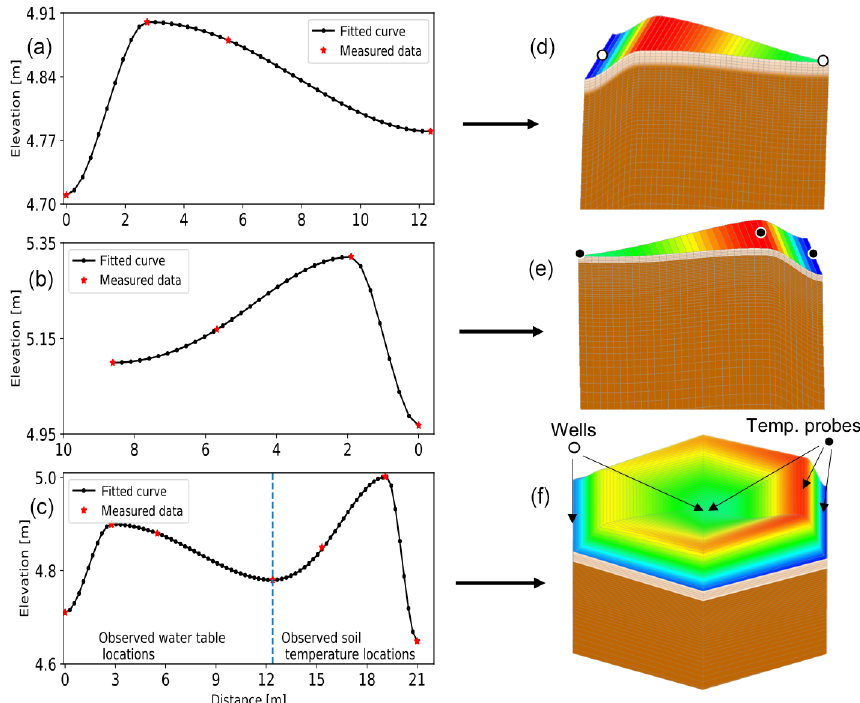
Figure 2. Construction of generic meshes from the observed elevations at the microtopographic locations (trough, rim, and center). Red asterisks represent measured elevation, black dots show spatial resolution ( ∼ 25cm), and black solid lines correspond to a spline fit to the measured elevation with zero slope at the locations trough, rim, and center. Panel (f) combines the transects where the water level and soil temperature measurements were made. (f) First a 2D surface is constructed from transect representing generic surface topography and then extended to 50m below the surface using variable vertical resolution. Wells and thermistor probe locations are highlighted in white and black dots, respectively. The color palette in (d) – (f) corresponds to the elevation in the plots in (a) – (c) and is different than the color range provided in Fig. 1b and